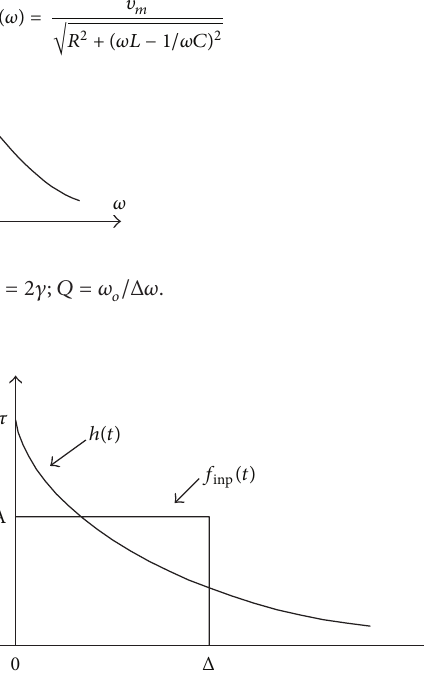
Figure 8: The functions for the simplest example of convolution. (A first-order circuit with an input block pulse.)